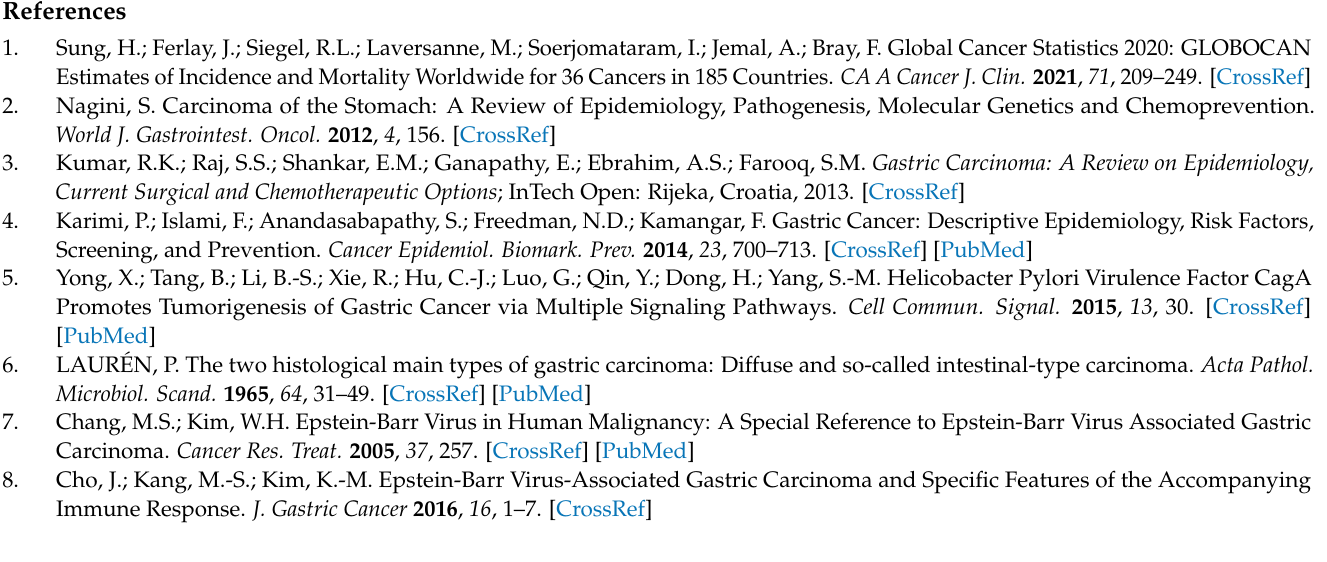
Figure S2: Differential expression of IRX2, IRX3, IRX4, IRX5 and IRX6 isoforms in GC versus normal tissue within the STAD TCGA cohort. Bar-plot panel present the isoform usage (from 0% to 100%) distribution (plotted using GEPIA2 software); Figure S3: Overall survival curves related to Iroquois family gene expression levels in GC patients considered as a whole and separated by CGI and CGD subtypes (plotted using KM plotter